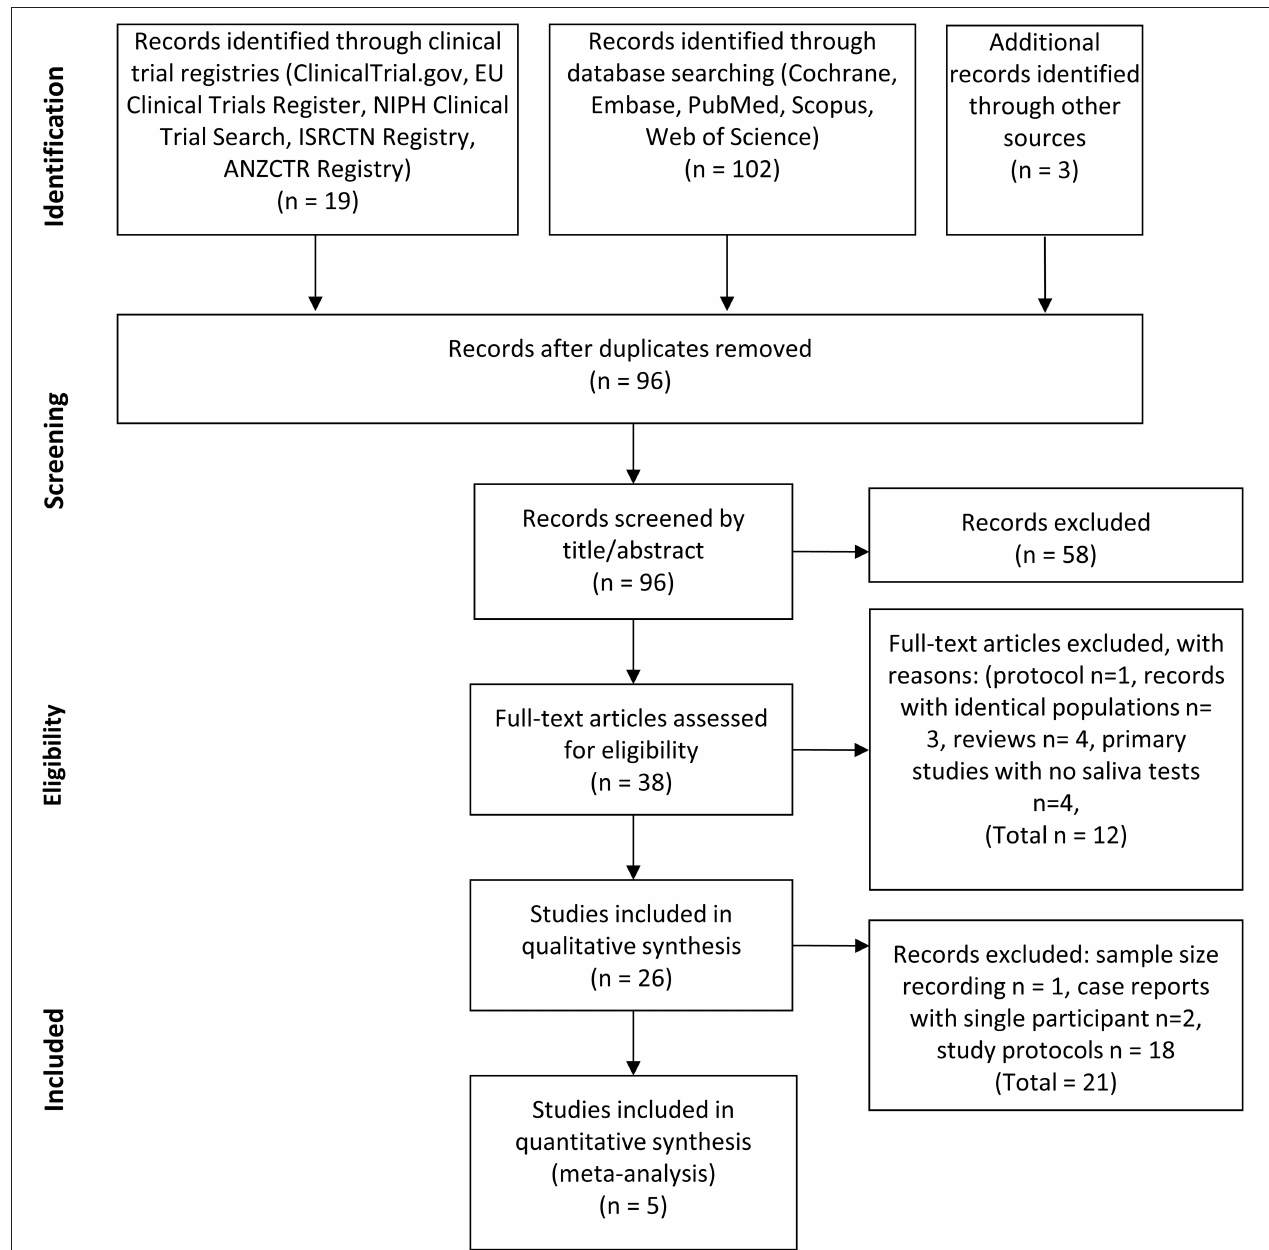
FIGURE 1 | PRISMA flow diagram of the study selection process. Flow chart illustrating the selection process for identifying eligible